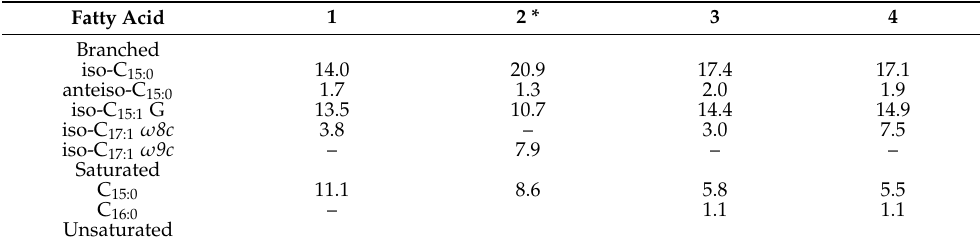
Table 3. Cellular fatty acid composition (%) of strain 36-CHABK-3-33 T and related species of the genus Zobellia